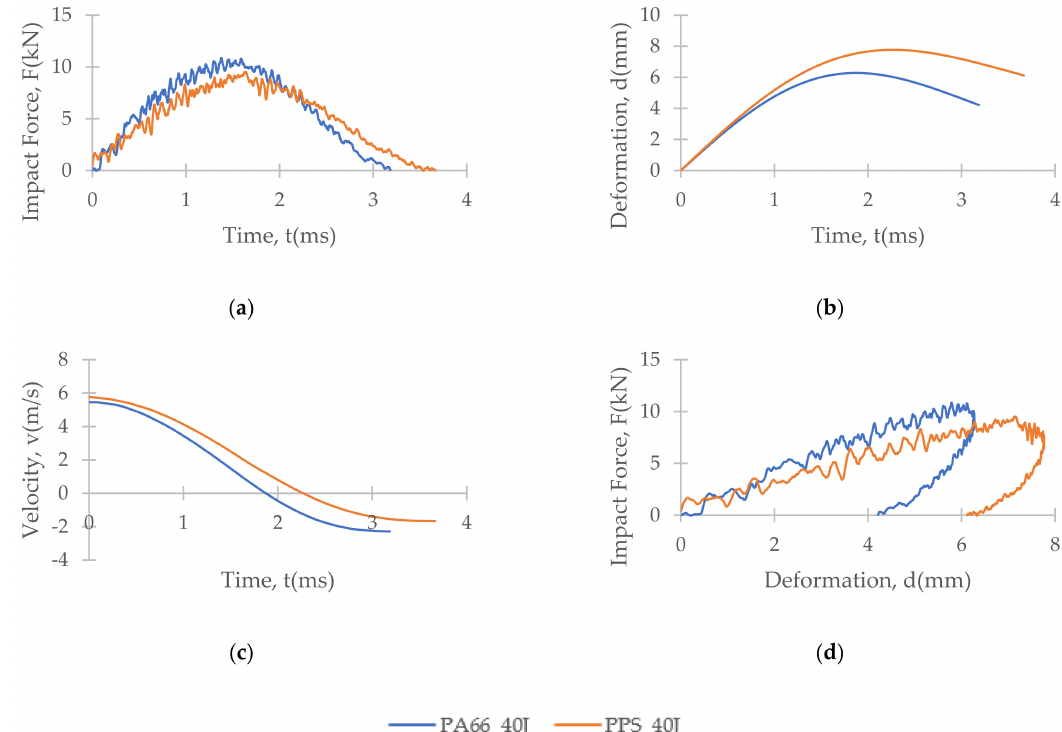
Figure 7. Time histories: ( a ) force-time, ( b ) deformation-time and ( c ) velocity-time; and ( d ) force-displacement plot of